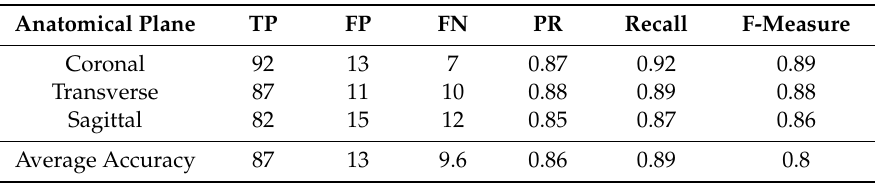
Table 4. Detection result